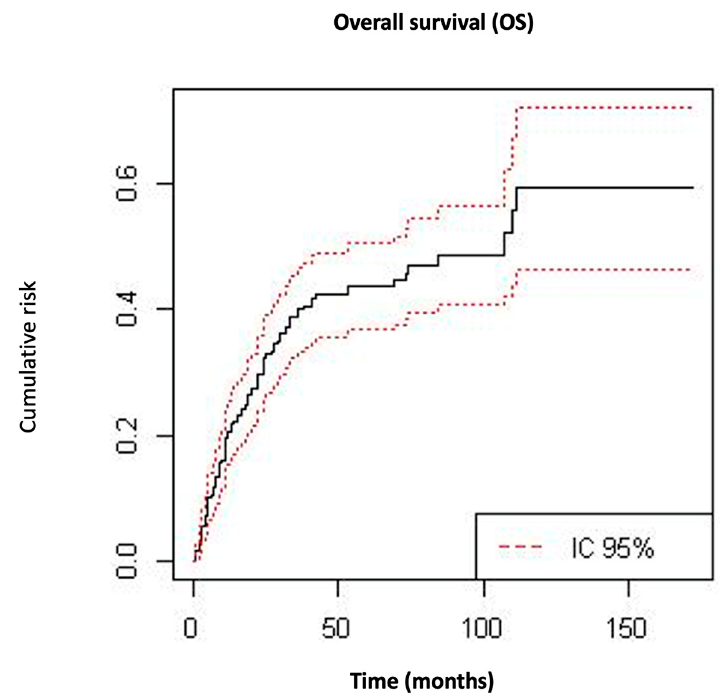
Figure 1. Kaplan–Meier curves for overall survival.